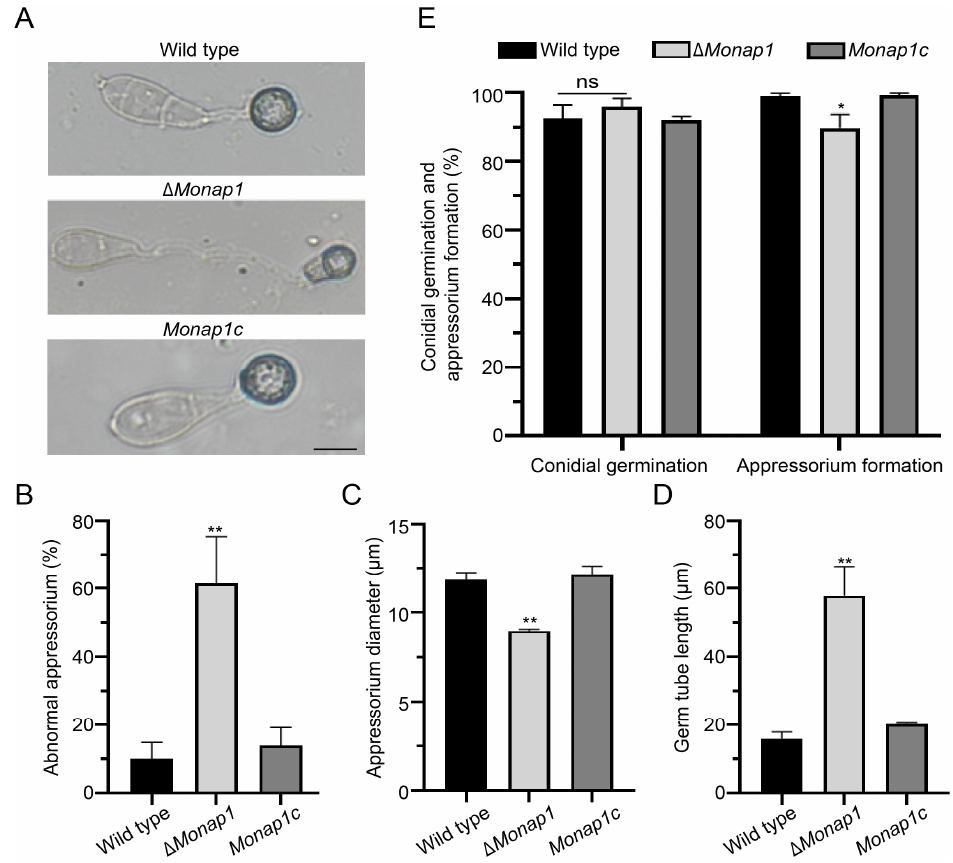
Figure 3. NAP1 is required for appressorium formation. ( A ) Appressorium formation in the wild- type, ∆ Monap1 an d Monap1c strains on hydrophobic surfaces at 24 hpi. Bar, 10 µ m. ( B ) Abnormal appressoria rates (%) in the wild-type, ∆ Monap1 and Monap1c strains. At least 150 spores were counted per replicate. n = 3 independent biological replicates. Error bars represent the standard deviations. The data were analyzed by GraphPad Prism 8.0 and significant differences compared with the wild type were estimated by multiple t tests: ** p < 0.01. ( C ) The appressorium diameter in the wild-type, ∆ Monap1 and Monap1c strains at 24 hpi. At least 150 spores were counted per replicate. n = 3 independent biological replicates. Error bars represent the standard deviations. The data were analyzed by GraphPad Prism 8.0 and significant differences compared with the wild type were estimated by multiple t tests: ** p < 0.01. ( D ) Germ tube length ( µ m) in the wild-type, ∆ Monap1 and Monap1c strains. Approximately 100 appressoria were photographed and measured using the software NIS-Elements D 3.2 in triplicate. At least 150 spores were counted per replicate. n = 3 independent biological replicates. Error bars represent the standard deviations. The data were analyzed by GraphPad Prism 8.0 and significant differences compared with the wild type were estimated by multiple t tests: ** p < 0.01. ( E ) Conidial germination rate (%) at 4 hpi and appressorium formation rate (%) at 24 hpi in the wild-type, ∆ Monap1 and Monap1c strains. At least 150 spores were counted per replicate. n = 3 independent biological replicates. Error bars represent the standard deviations. The data were analyzed by GraphPad Prism 8.0 and significant differences compared with the wild type were estimated by multiple t tests: ns, p > 0.05, * p < 0.05. The complementation strain Monap1c recovered the mutant’s defects in mycelial growth, sporulation, conidiophore formation, and conidium differentiation, indicating that the defects in growth and conidiation of ∆ Monap1 were caused by the deletion of NAP1 . We also complemented ∆ Monap1 with the NAP1 gene of S. cerevisiae and found that NAP1 in S. cerevisiae can restore the sporulation and virulence of the ∆ Monap1 mutant but not the growth of ∆ Monap1 (Figure